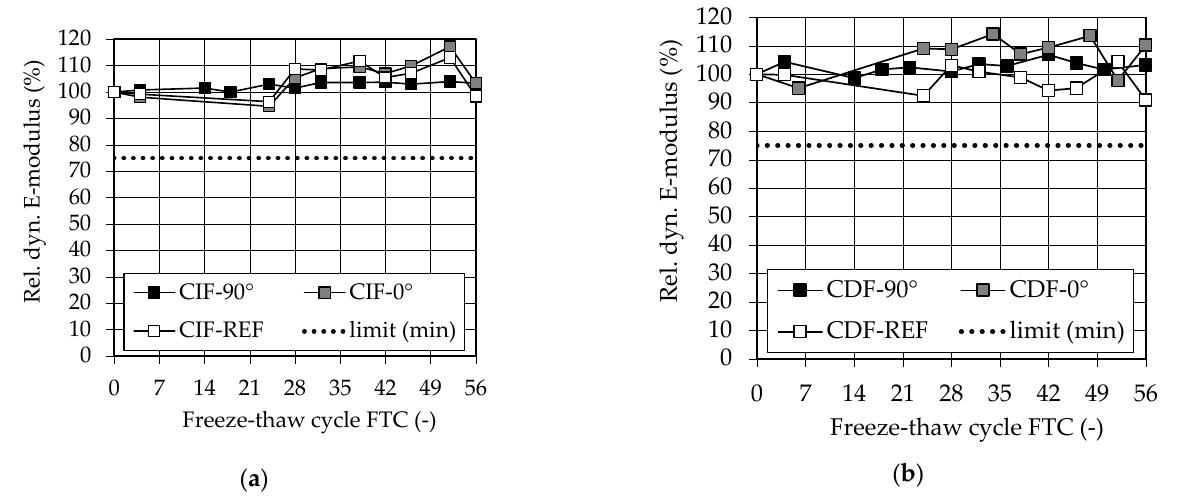
Figure 13. Rel. dyn. E-modulus of ( a ) CIF specimens and ( b ) CDF specimens.